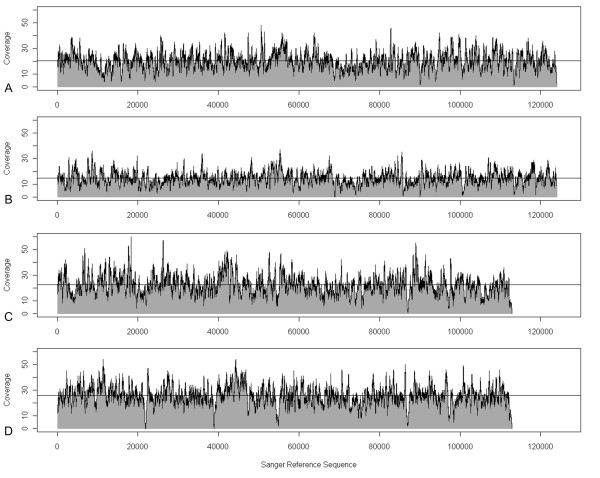
Read distribution on Sanger Reference Sequences. Reads for BAC 259I16 from set 1 (A), set 2 (B) and BAC 711N16 from set 1 (C) and set 2 (D) are mapped versus the Sanger reference sequence (Acc. no. AY268139, AF427791 (pos. 1 to 112,920)). The horizontal line indicates the average read coverage.